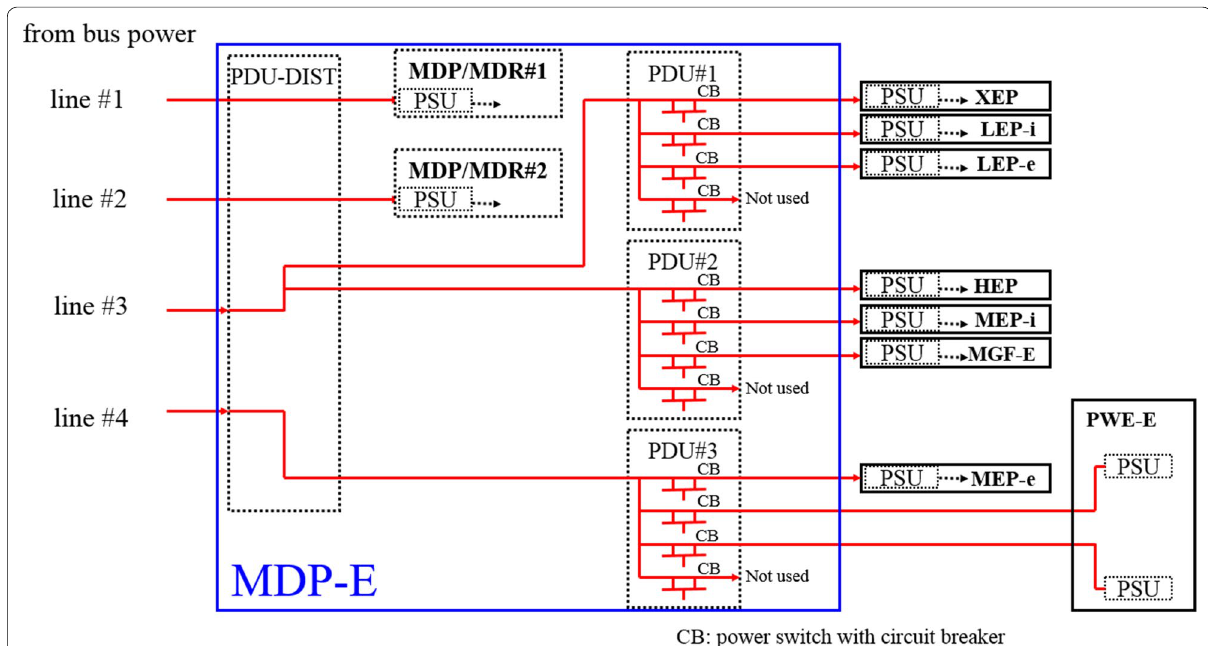
Fig. 3 The diagram of mission power lines. Four power lines come from the bus power control unit independently. Two lines are connected to MDP-1/MDP-2 directly and the other lines are connected to three PDU (PSD#1–PSD#3). Power lines are distributed to each switch with a circuit breaker that controls the sensor for power on/off in